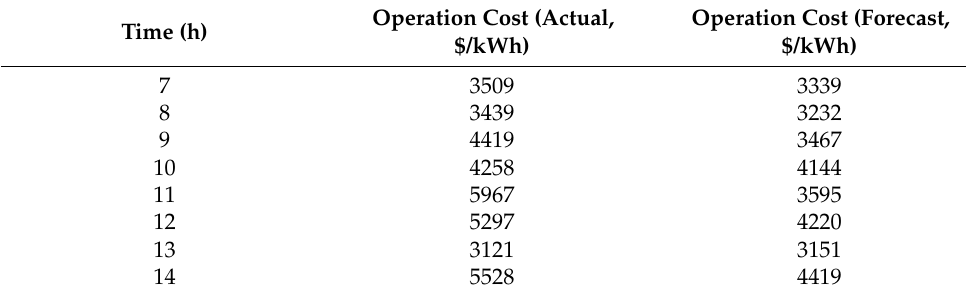
Figure 9. Aggregate load reshapes with forecast PV and wind data. Table 2. Comparison of operational cost with RES